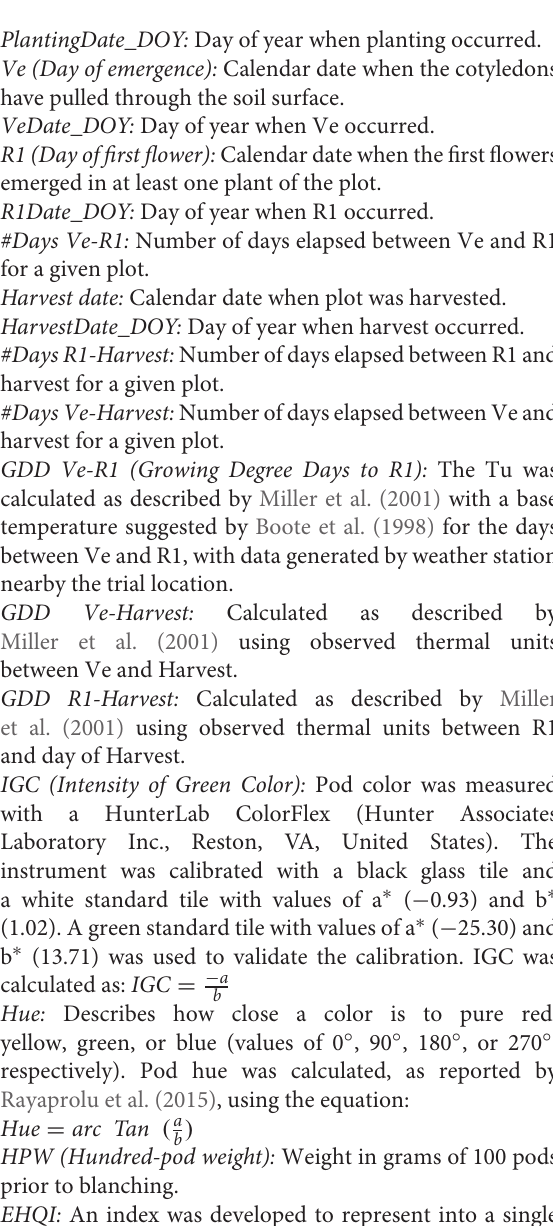
approximately 16 seeds per meter row at emergence. The plots were managed using standard agricultural practices for irrigation, fertilizer, and pesticides. At harvest, a total